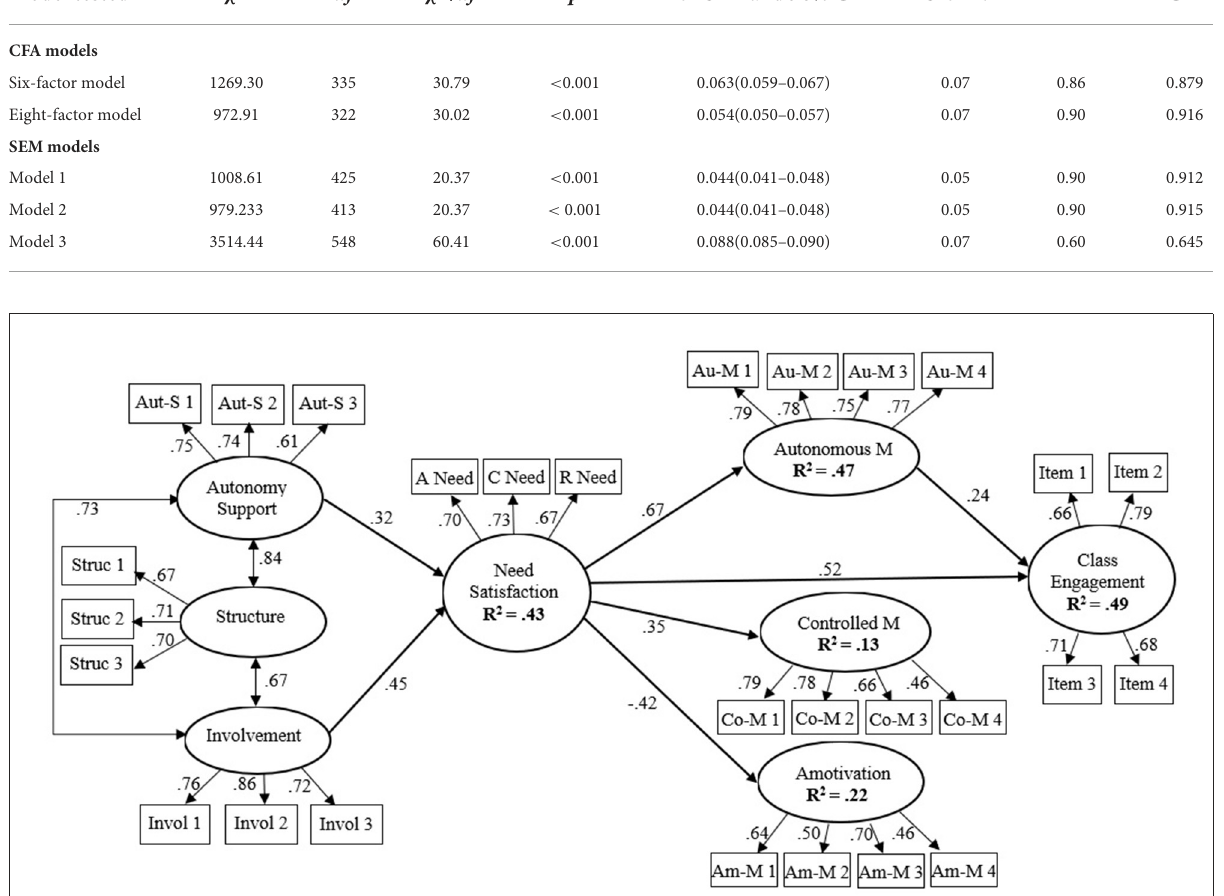
FIGURE1 The structural model of the relations between teacher support, need satisfaction, motivation, and engagement among Chinese college students. All presented path coefficients are standardized and significant ( p < 0.05). To avoid cluttering, this figure did not depict the non-significant path coefficients, the correlations between three subtypes of motivation, and the covariates (gender, grade, area, and major). Aut-S 1-3, Invol 1-3, and Struc 1-3 are the parcels for autonomy support, involvement, and structure, respectively. A Need, C Need, and R Need represented the needs for autonomy, competence, and relatedness, respectively. Autonomous M and Controlled M represented autonomous motivation and controlled motivation, respectively. Au-M 1-4, Co-M 1-4, and Am-M 1-4 are the parcels for autonomous motivation, controlled motivation, and amotivation, respectively. Gender, grade, family site, and major were not depicted for clarity, although they were controlled. The correlations of three teacher support dimensions and three motivation subtypes were as follows: r autonomous motivation and controlled motivation =